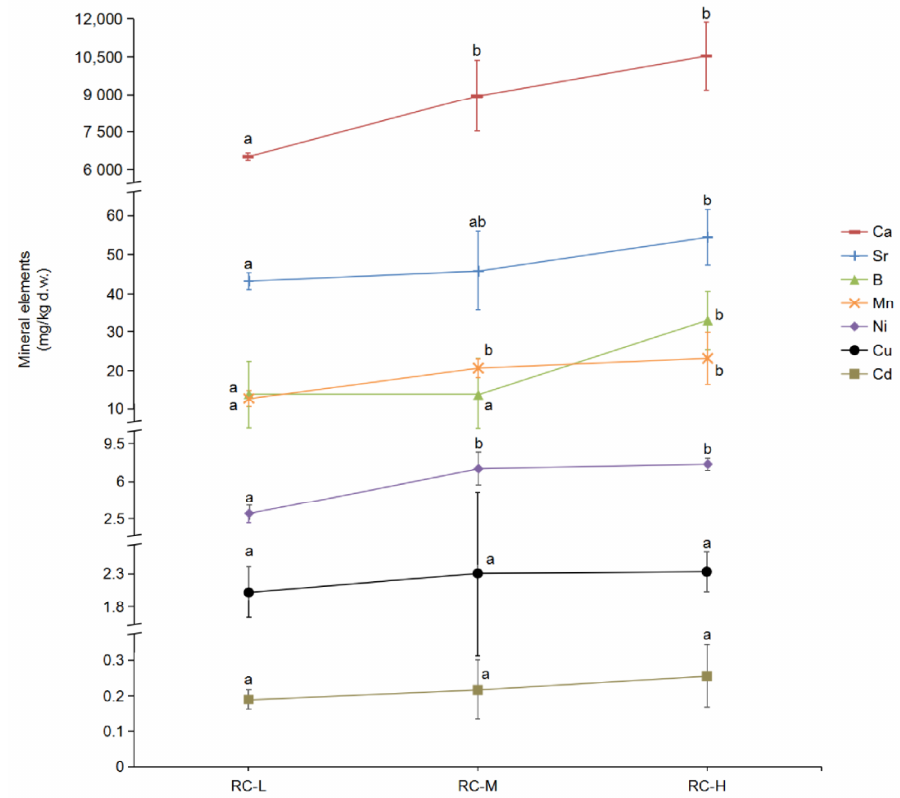
Figure 2. Accumulations of seven mineral elements in rhizomes of Rhodiola crenulata (RC-L, RC-M, and RC-H) from different altitudes (3933, 4249 and 4531 m), respectively. Calcium (Ca); Strontium (Sr); Boron (B); Manganese (Mn); Nickel (Ni); Copper (Cu); Cadmium (Cd). Results are presented as the mean ± SD of four independent experiments ( n = 4). Different letters (a, b) mean significant differences between two groups ( p < 0.05) found via a t -test. Note: Rhodiola crenulata samples are presented according to the ascending order of altitude from left to